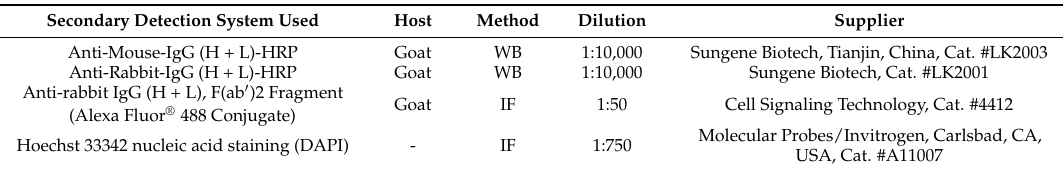
Table 2. List of secondary antibodies and counterstaining of